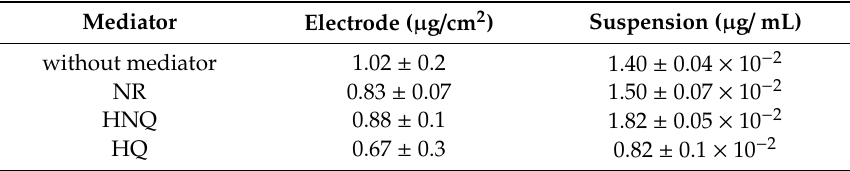
Table S2: Estimation of carbon recovered into biomass according to each cycle of headspace gas replacement. Figure S1: Schematic diagram of microbial electrosynthesis reactor, Figure S2: Acetate production at 0.5 mM and 1 mM, Figure S3: Average electron recovery into acetate with 0.1 mM, 0.5 mM, and 1 mM of redox mediators during eight cycles. Figure S4: Average carbon recovery into acetate at 0.1 mM, 0.5 mM, and 1 mM of